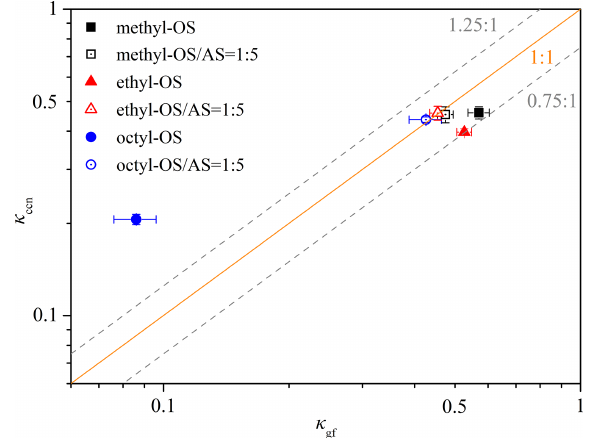
Figure 8. Comparison of κ values derived from hygroscopic growth ( κ gf ) with those derived from CCN activities ( κ ccn ) for methyl-, ethyl- and octyl-OS aerosols as well as their internal mixtures with ammonium sulfate (the mass ratio was